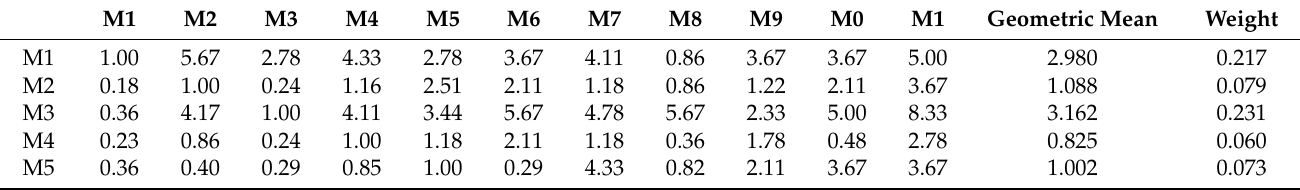
Table 7. The paired comparison matrix of the evaluation